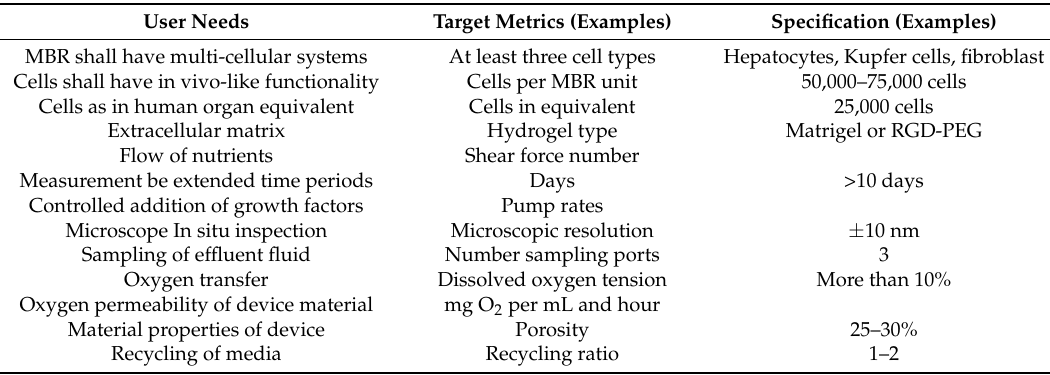
Table 2. User needs of a micro-bioreactor with organ